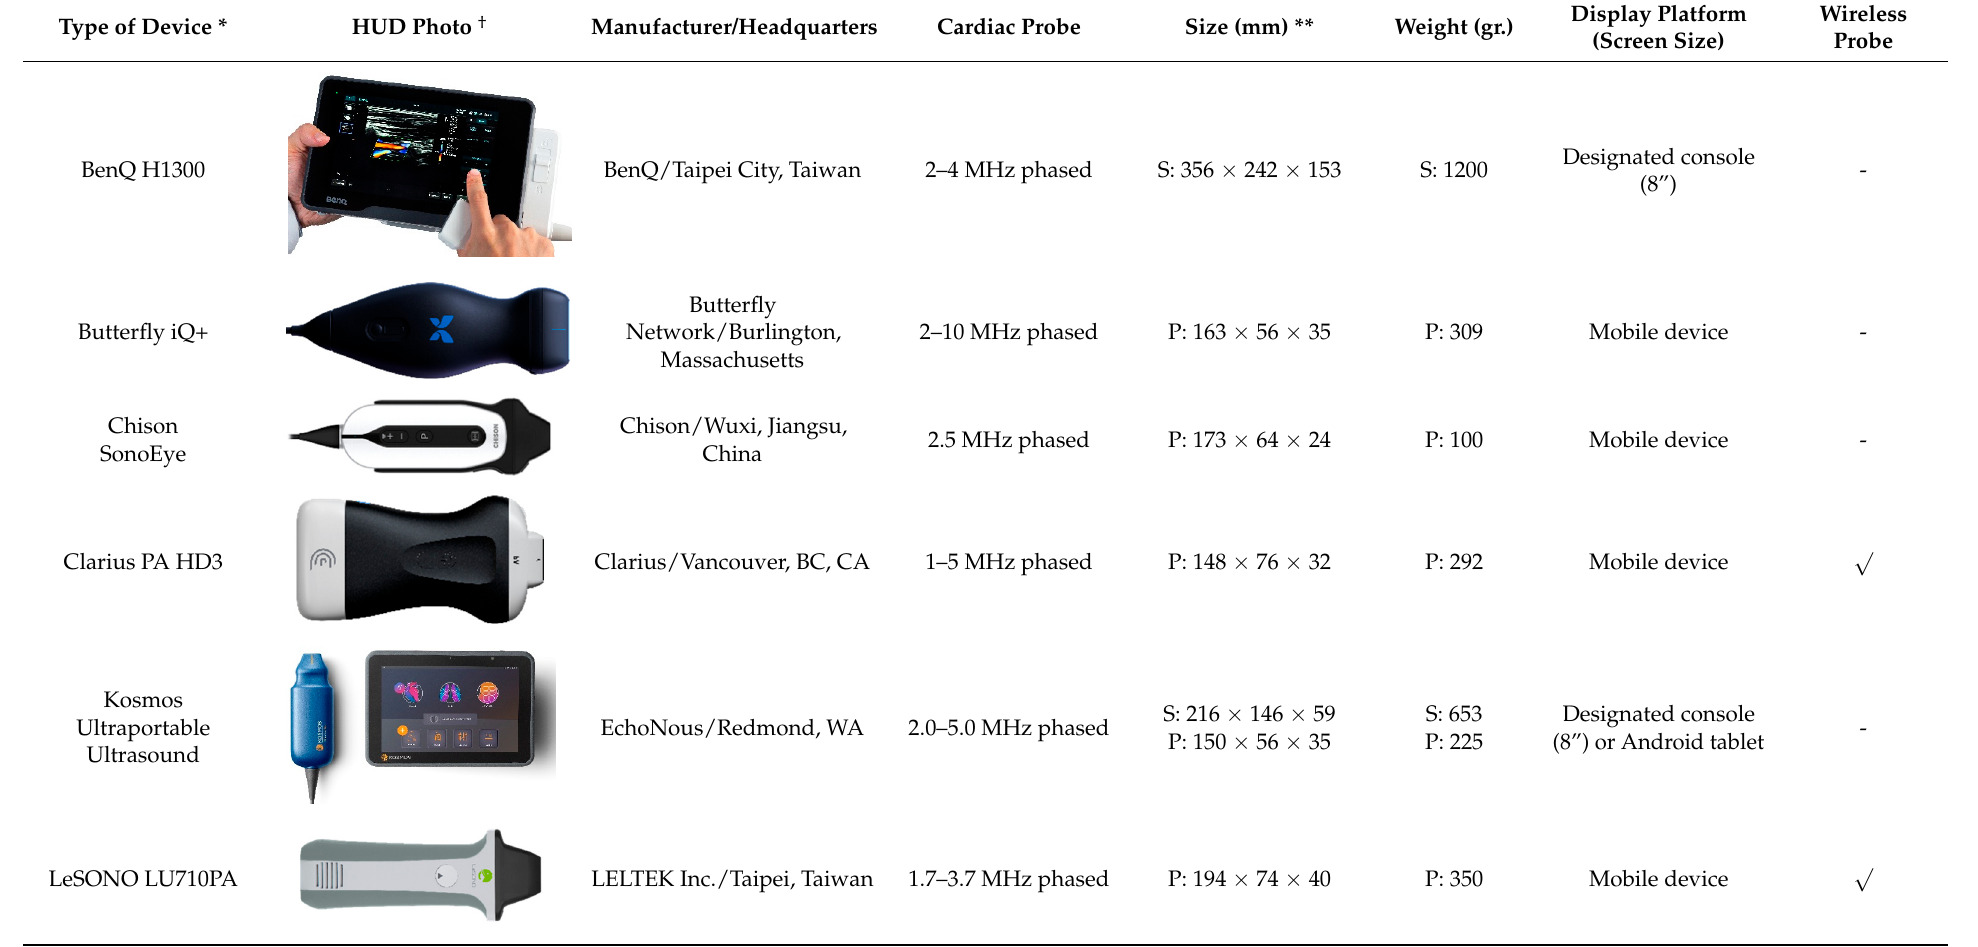
Table 2. Examples of different type and manufacturer of cardiac HUD.